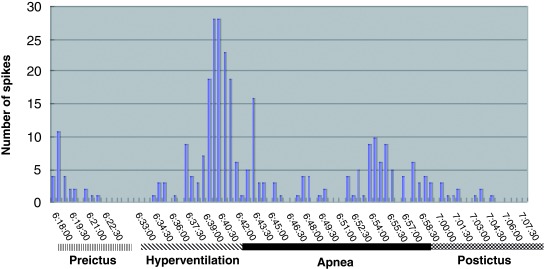
Positive spike frequency histogram.Frequency histogram analysis of positive electroencephalographic spikes in an 18-year-old woman with recurrent, prolonged, post-hyperventilation apnea. Positive spikes were marked, in particular, during hyperventilation, which was interpreted as autonomic epileptic seizures. Quoted from Nagayama
9.